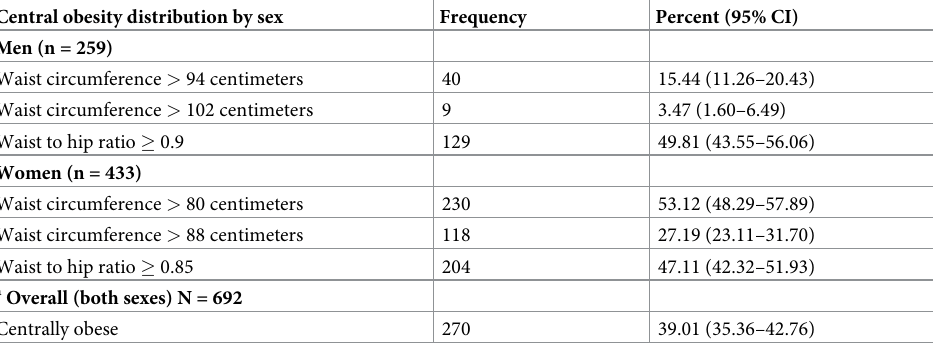
Table 4. Distribution of central obesity by sex among adult populations in administrative towns of Bale zone, Southeast Ethiopia, 2021. Central obesity distribution by